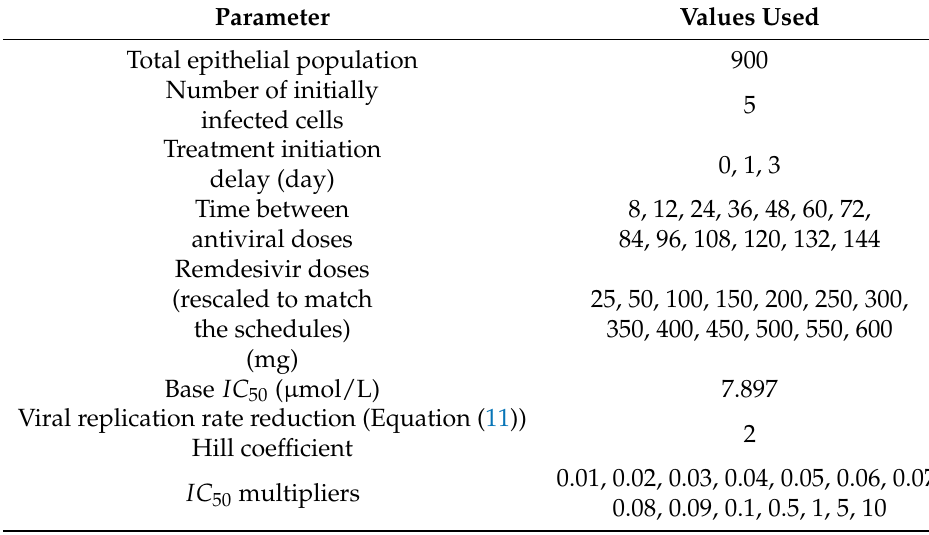
Table 2. List of parameters for the ABM and PD models as well as parameters varied for the treatment effectiveness